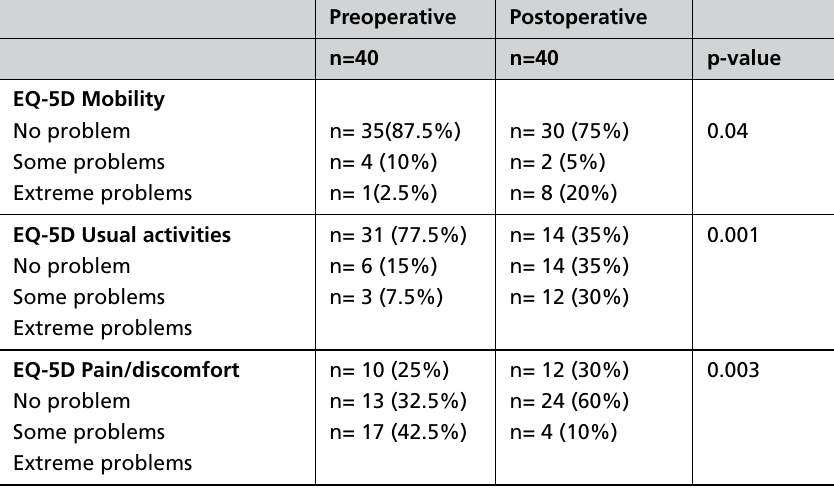
Table 3: Comparison of pre and post- operative BI item scores (n=40)